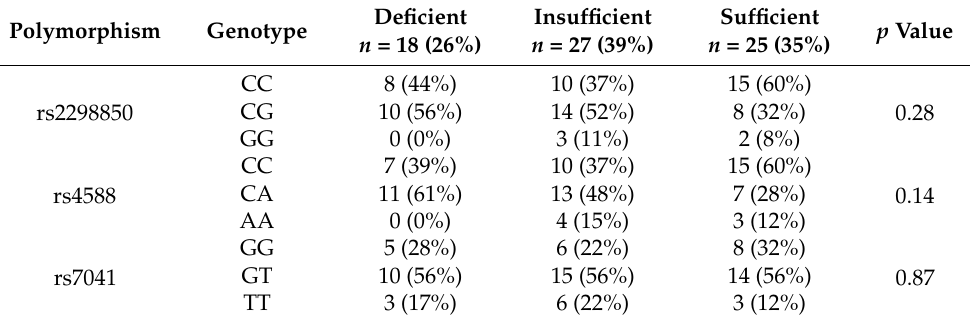
Table 6. Distribution of maternal vitamin D status according to maternal VDBP